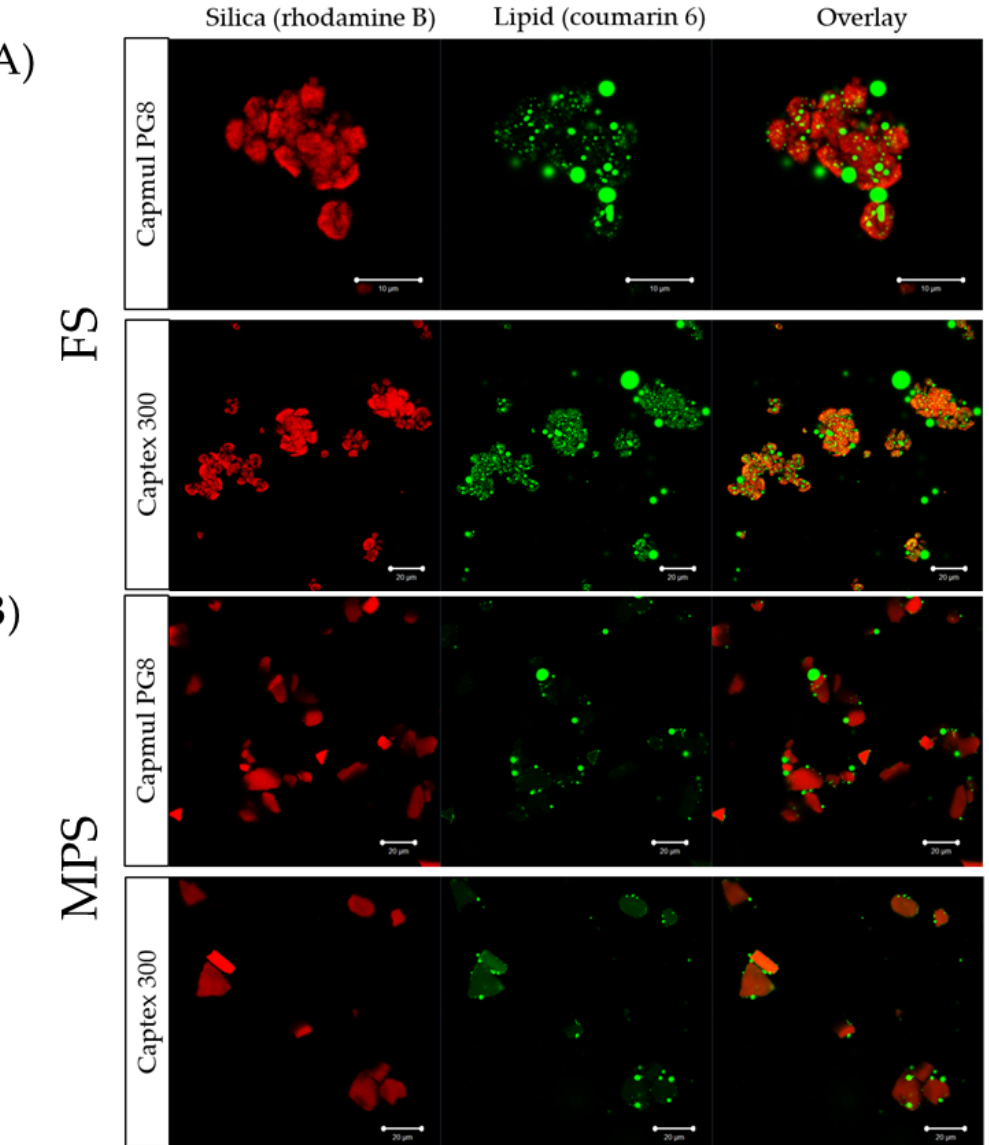
Figure 4. Confocal images of: ( A ) SLH prepared with FS and ( B ) SLH prepared with MPS. Rhodamine B (red) was used to label silica, and coumarin 6 (green) was used to label lipid.